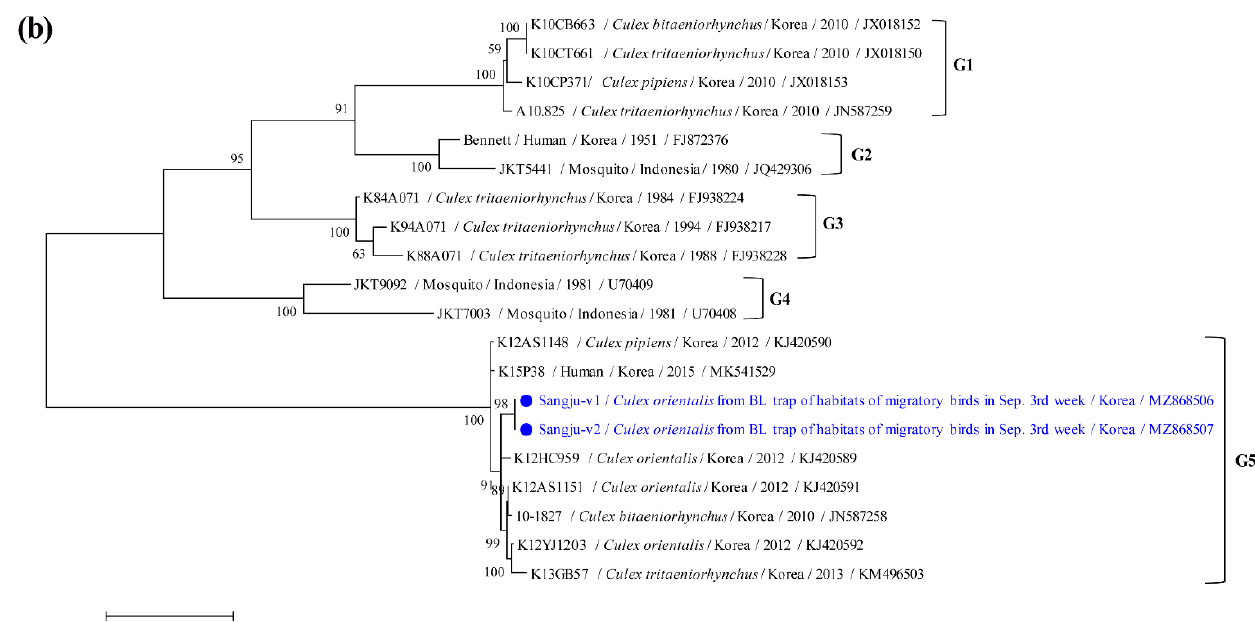
Figure 5. Phylogenetic tree of Japanese encephalitis virus (JEV) based on ( a ) non-structural protein 5 ( NS5 ) gene sequences and ( b ) envelope ( E ) gene sequences. The maximum likelihood method was used to plot the tree with the Kimura 2-parameter model. Closed circles and blue letters indicate sequences detected here. GenBank accession numbers are shown. JEV genotypic groups are indicated. Branch numbers indicate bootstrap support levels (1000 replicates). The phylogenetic tree is rooted at its midpoint rooting. Scale bar displays substitution numbers for each nucleotide.